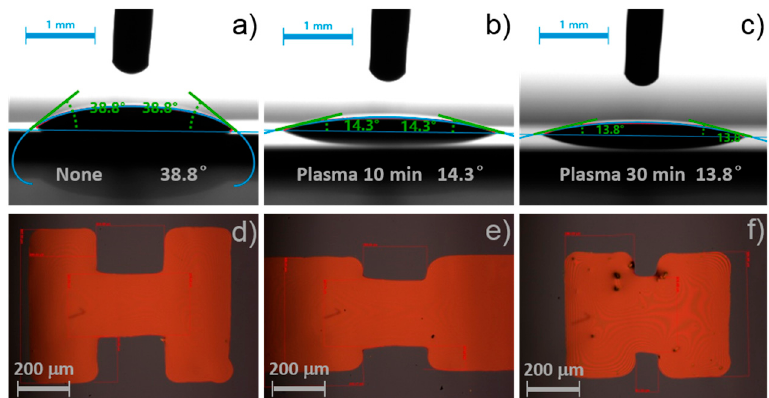
Figure 3. Contact angle between the ink and the substrate without ( a ) and with argon plasma treatment for 10 min ( b ) and 30 min ( c ). ( d – f ) Microscope images of different sized printed channel patterns on the substrate treated with plasma treatment for 10 min.